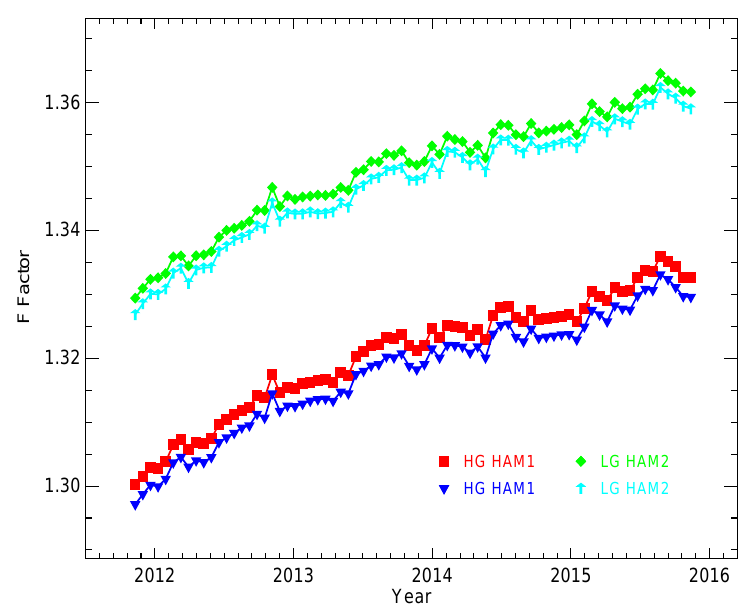
Figure 8. VIIRS band M1 detector-averaged SD F-factors. The detector-averaged F-factors for all RSB with high-gain status and HAM 1 are displayed in Figure 9. The F-factors for non-SWIR bands are normalized at the first measurement. The SWIR bands were normalized on 20 January 2012 when the temperature of the S/MWIR FPA started to be controlled. The SWIR bands were not stable and usable before 20 January 2012. The F-factors shown